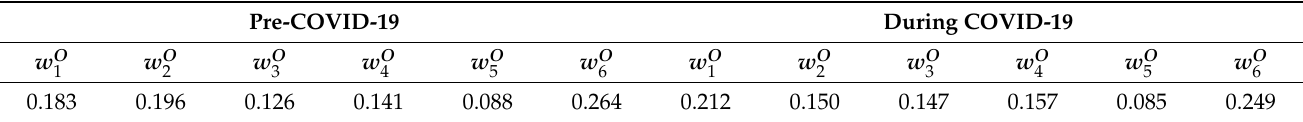
Table 9. The objective weights of bank productivity criteria pre-and during COVID-19. Pre-COVID-19 During COVID-19